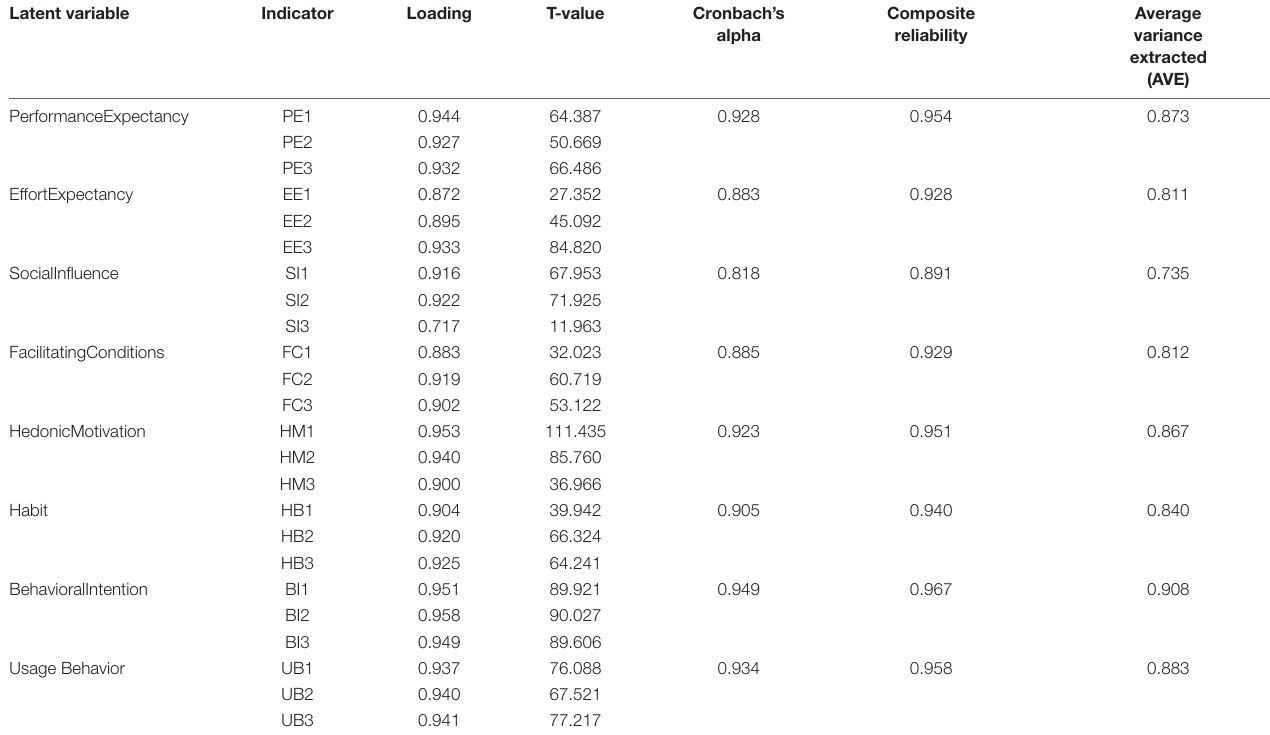
TABLE 4 | Loading factor, validity, and reliability.